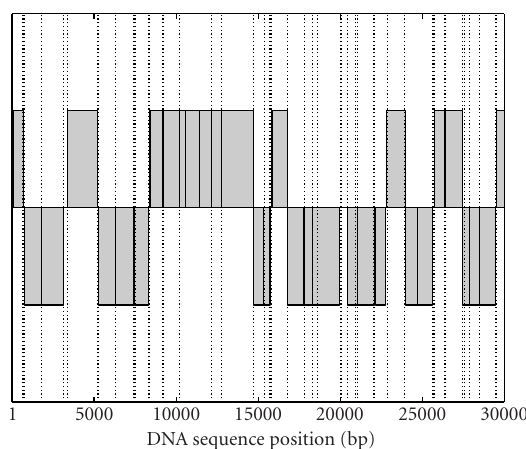
Figure 11: Comparison between the known coding regions (gray regions with solid lines as borders) of a DNA sequence from bacte- ria Borrelia burgdorferi and the borders (vertical dashed lines) ob- tained through recursive segmentation using Jensen-R´enyi diver- gence ( α = 0 . 5), (cid:1) 18 alphabet, and standard stopping criterion. The coding regions oriented downwards are situated on the oppo- site DNA strand.